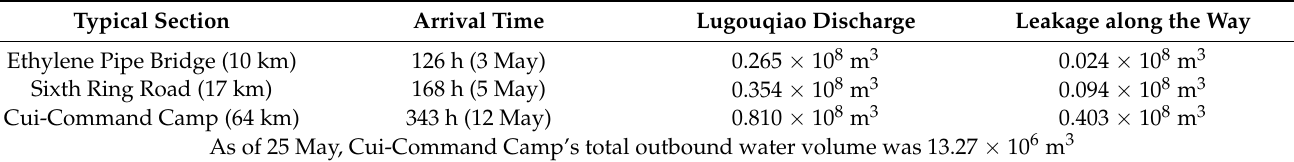
Table 5. The results of the water flow routing process in spring